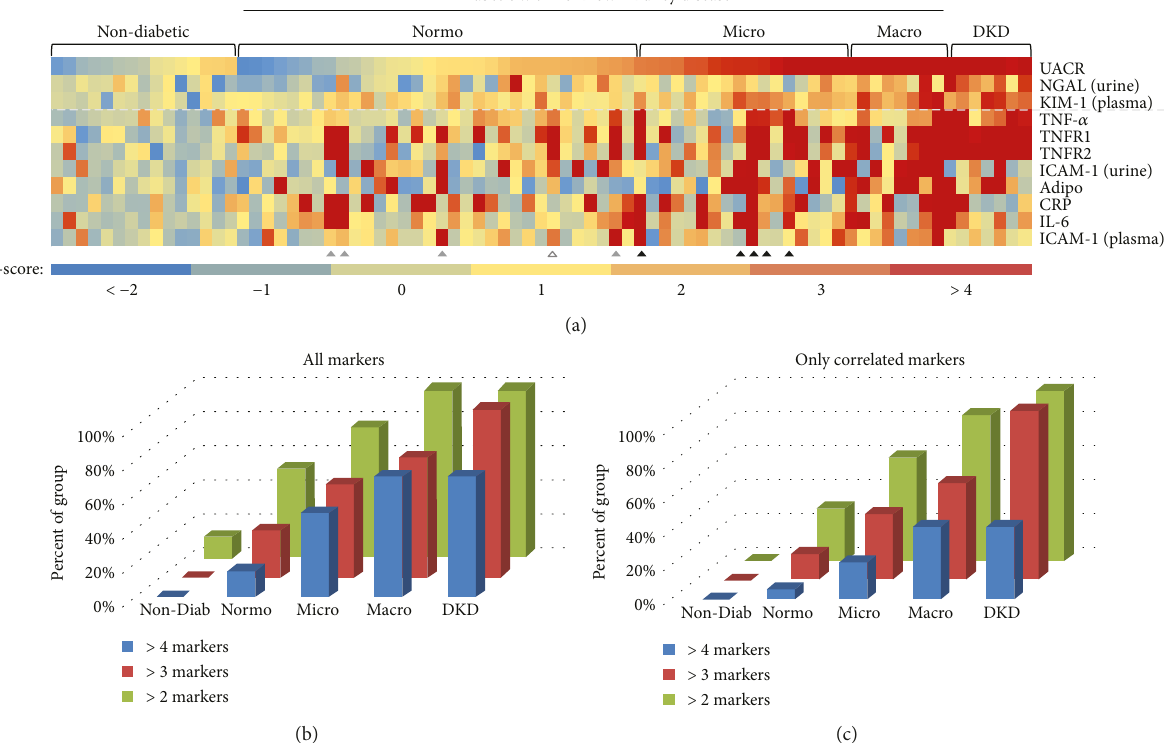
Figure 5: (a) Heat map showing the relative levels of 11 markers from subjects from di ff erent subgroups based on albuminurea. Each column represents one subject from our study, with the level of each of the 11 markers indicated by a Z-score relative to the mean of the nondiabetic controls for that marker. The relative levels of 3 kidney injury markers (i.e., log-transformed UACR, urinary NGAL and plasma KIM-1) are shown above the dashed line while the relative levels of 8 in fl ammation markers are shown below the dashed line. Higher Z-scores are represented by warmer colors while lower Z-scores are represented by cooler colors. Individuals who exhibited elevated Z-scores for at least 3 of the correlated in fl ammation markers, despite being in the normoalbinurea group (grey triangles) or the microalbinurea group (black triangles) based on UACR, are indicated. (b) Percentage of subjects from each group with between 2 and 4 in fl ammation markers whose levels were at least 2 standard deviations above the mean of the nondiabetic group, among all markers tested. (c) Percentage of subjects from each group with between 2 and 4 in fl ammation markers whose levels were at least 2 standard deviations above the mean of the nondiabetic group, among correlated markers only (i.e., plasma adiponectin, TNF- α , TNFR1, TNFR2, ICAM-1, and urinary